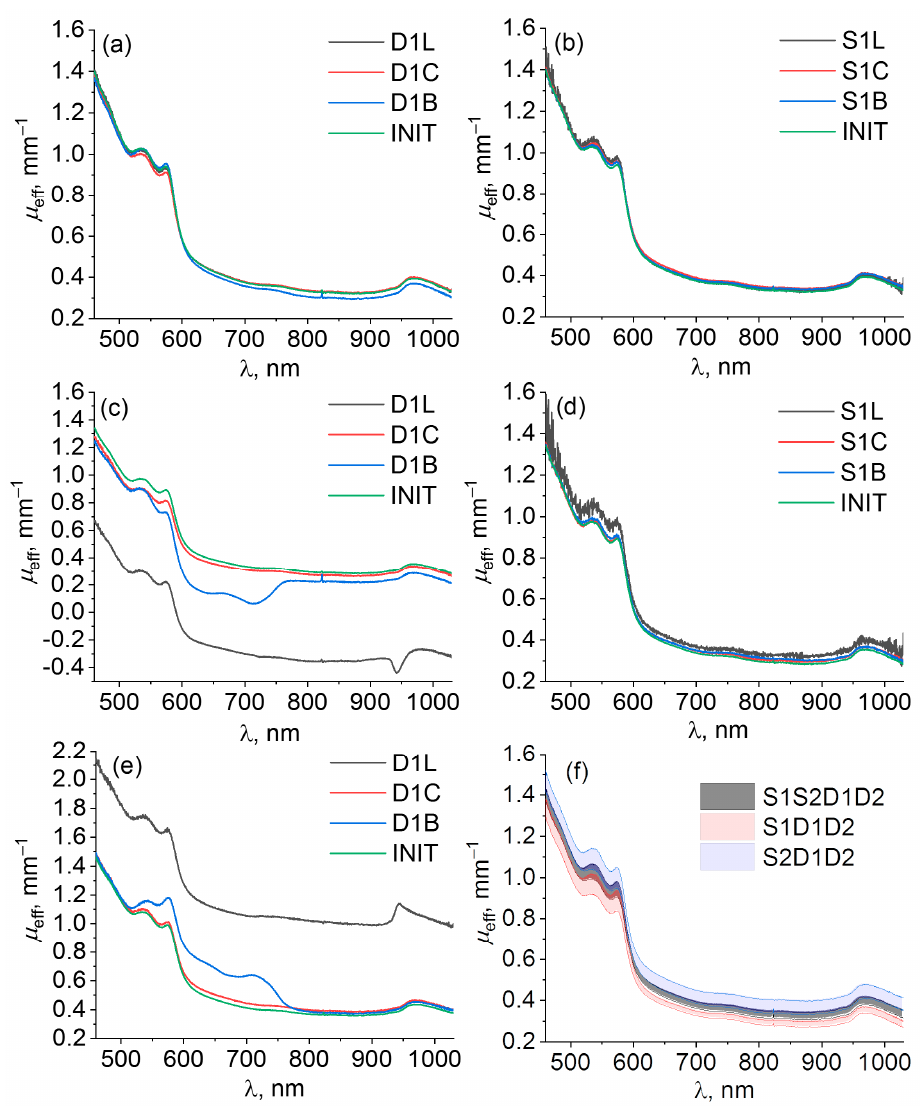
Figure 4. Examples of µ P , m spectra of a human palm calculated with self-calibrating approach S1S2D1D2 ( a , b ), and single-slope configurations S1D1D2 ( c , d ), and S2D1D2 ( e ) for different kinds of detector (left column) and source (right column) perturbations described in Table 1. Index m indicates individual measurements under particular perturbation P. Comparison of µ INIT spectra ( f ) obtained by three approaches S1S2D1D2 (gray), S1D1D2 (red), and S2D1D2 (blue) for unperturbed measurements shown as mean with confidence bounds.